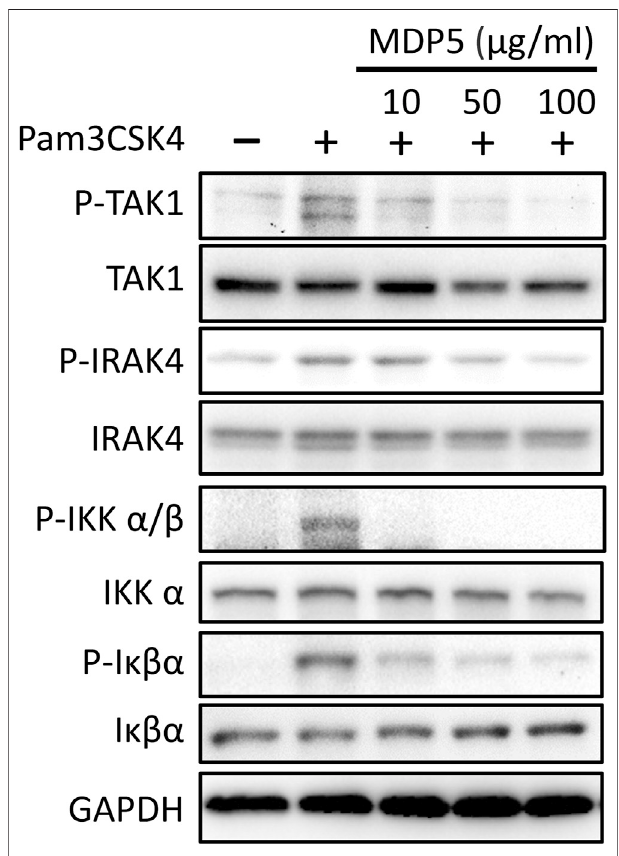
FIGURE 4 | MDP5 prevented NF- κ B signaling activation in BMDMs. BMDMs were pretreated with MDP5 (10 – 100 ug/ml)) for 2 h then stimulated with Pam3CSK4 for 1 h. Activation of signaling in BMDMs is shown by immunoblots using the indicated antibodies.